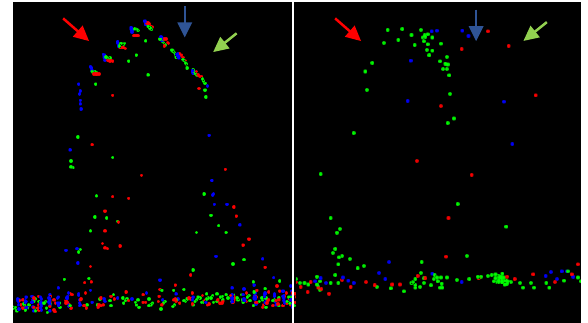
Figure 10. Point cloud for Target T1, showing strip alignment noise in Flight 1(left) and Flight 4 (right); blue: Strip 1; Green: Strip 2; and red: Strip 3. (Arrows marks angle of incidence per